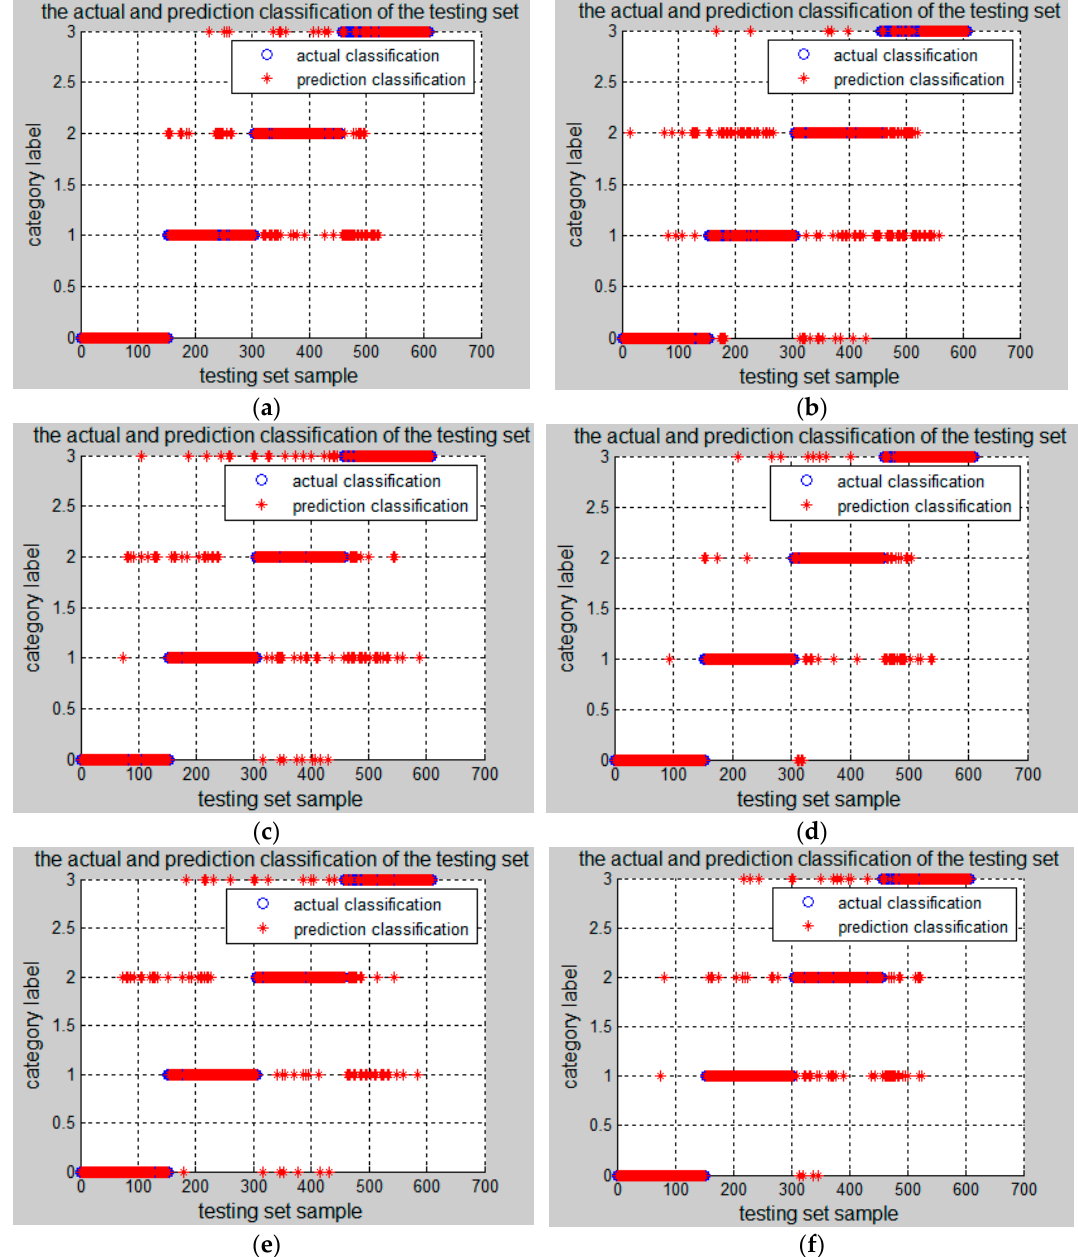
Figure 6. Testing results of PSO-SVM using different input features. ( a ) using time-domain features only; ( b ) using frequency-domain features only; ( c ) using IEMD energy entropy features only; ( d ) using time-domain + frequency-domain features; ( e ) using frequency-domain + IEMD energy entropy features; and ( f ) using time-domain + IEMD energy entropy features.